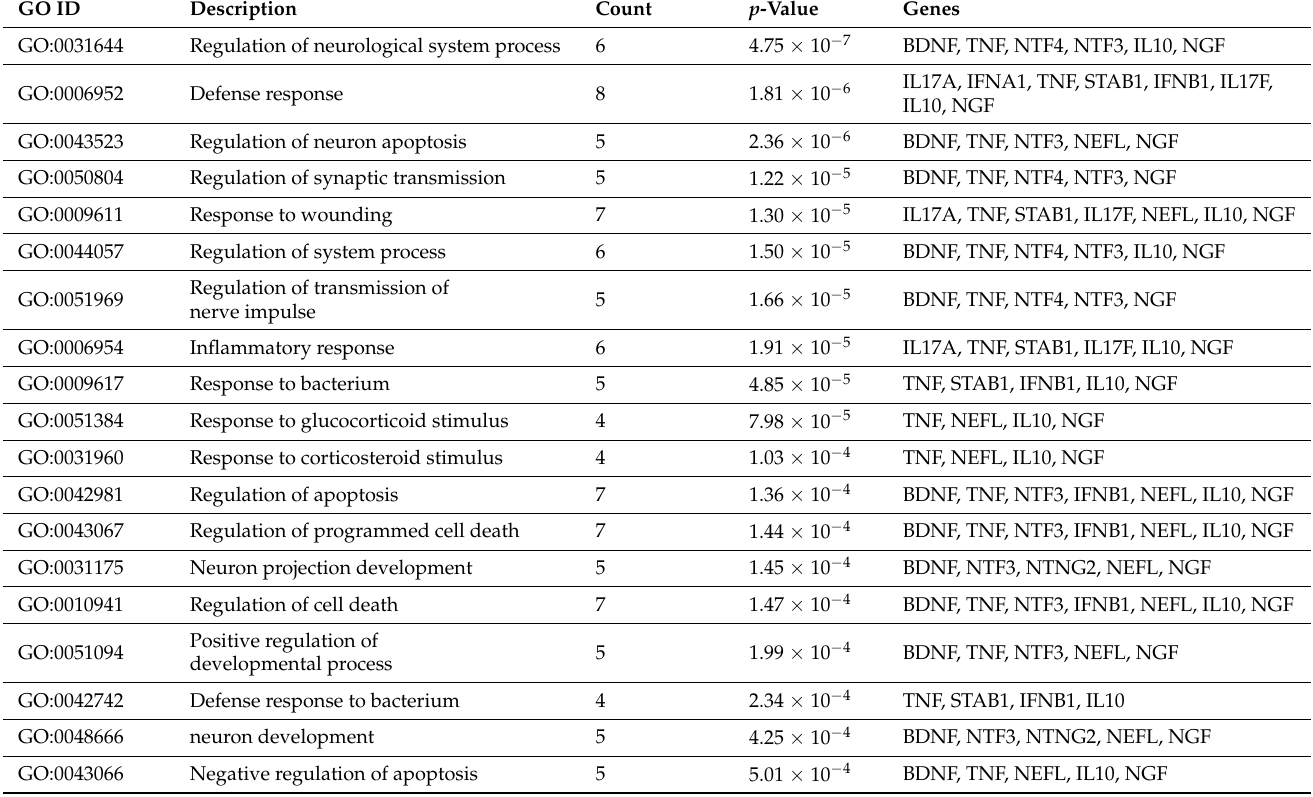
Table 1. GO analysis biological process (BP) of genes associated with cognitive dysfunction in